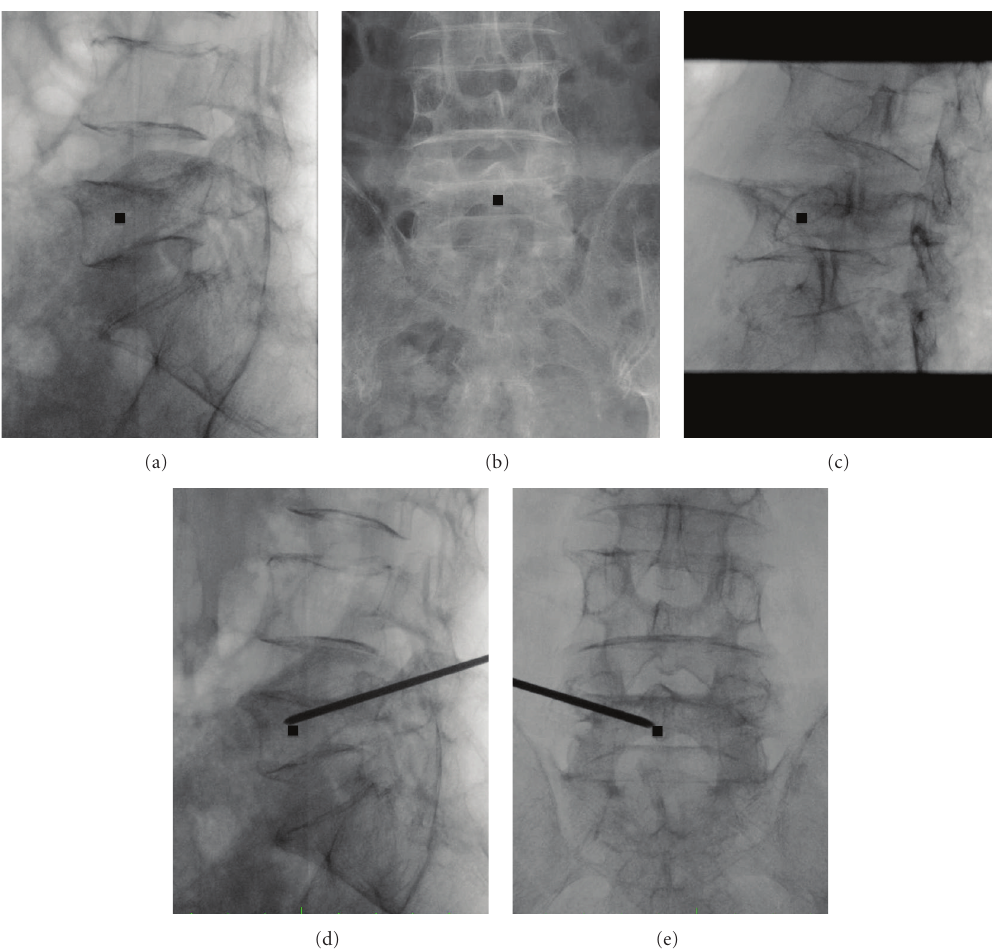
Figure 1: ISOcenter puncture method. (a) Positioning: lateral view. (b) Positioning: frontal view. The examining table is moved with the monitor screen used for fluoroscopic viewing of the front and lateral images until the puncture target overlaps the isocenter marker. (Arrow: Isocenter marker.) (c) Rotation of the C-arm. The C-arm is rotated in a three-dimensional manner until the isocenter marker overlaps the center of the pediculus arcus vertebral image. (d) Puncture: lateral view. (e) Puncture: frontal view. Puncture is conducted while targeting the isocenter marker under fluoroscopic guidance. Following penetration of the bony cortex of the vertebral arch pedicle, the needle is advanced up to the target indicated by the isocenter marker, under frontal and lateral fluoroscopic